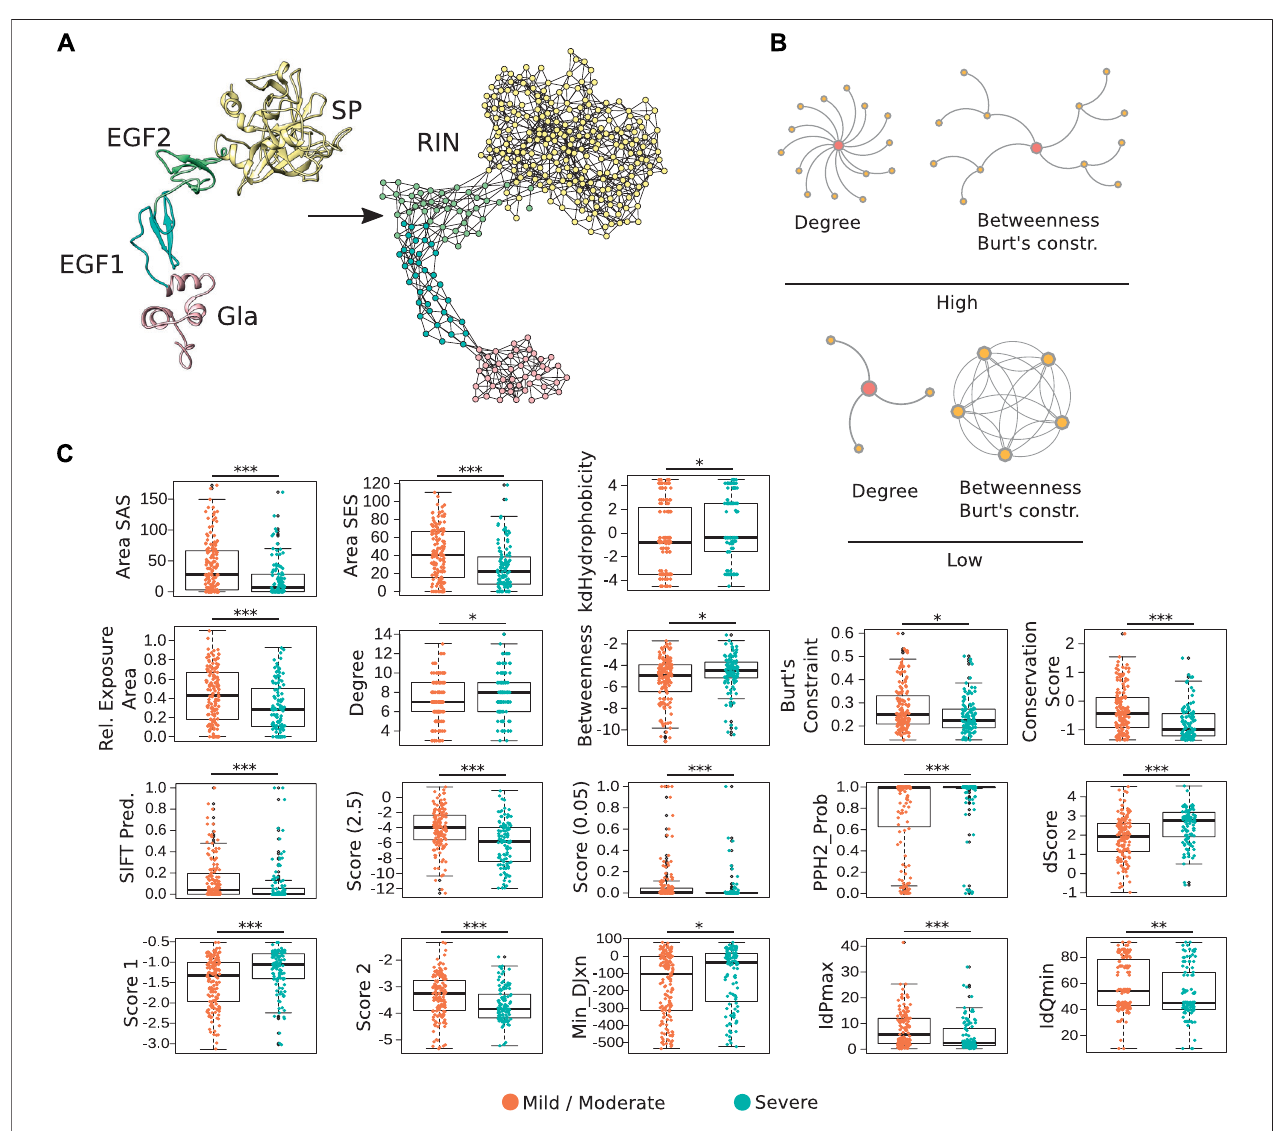
FIGURE 1 | Representation of FIXa structure as a residue network. (A) In the FIXa RIN, each node represents an amino acid, and two nodes are connected by an edge if their atoms are in close proximity (~5 Å). (B) The degree quanti fi es the number of connections a residue has, the betweenness indicates how many times a node served as a bridge on the shortest path along two other amino acids, and the Burt ’ s constraint was derived from social science studies to quantify the position of advantage of individuals within an organization (Burt, 2009). Nodes with high-degree participate in multiple molecular interactions, and those with high- betweennessandlowBurt ’ sconstraintserveasintermediate betweendifferentgroupsofaminoacids.Incontrast,residueswithlowdegree,lowbetweennessandhigh Burt ’ s constraint usually do not have many connections to other residues and are located at the periphery of the network. (C) Properties derived from the FIXa structure or from the RIN are good indicators of the severity of HB. Depicted is the solvent-accessible (areaSAS) and the solvent-excluded (areaSES) surface areas, the relative exposure of amino acids (Rel. Exposure Area), the conservation of the FIXa residues (smaller values indicate higher conservation), and the RIN centrality measures. Also depictedaremeasuresderivedfromSIFT(Simetal.,2012),Provean(2Scores, − 2.5and0.05)(ChoiandChan,2015),andfromPolyphen-2(PPH2-Prob,dScore,Score 1, Score 2, MinDJxn, IdPmax, IdQmin) (Adzhubei et al., 2010). The boxplots show the median (center line), the fi rst and third quartiles (lower- and upper-bounds), and 1.5 times the inter-quartile range (lower- and upper whiskers). Each dot in the plot is an amino acid mutation (i.e., a clinical case report). Unpaired, two-sided Wilcoxon test (*** p -values < 0.001; ** p -value < 0.01; * p -value <